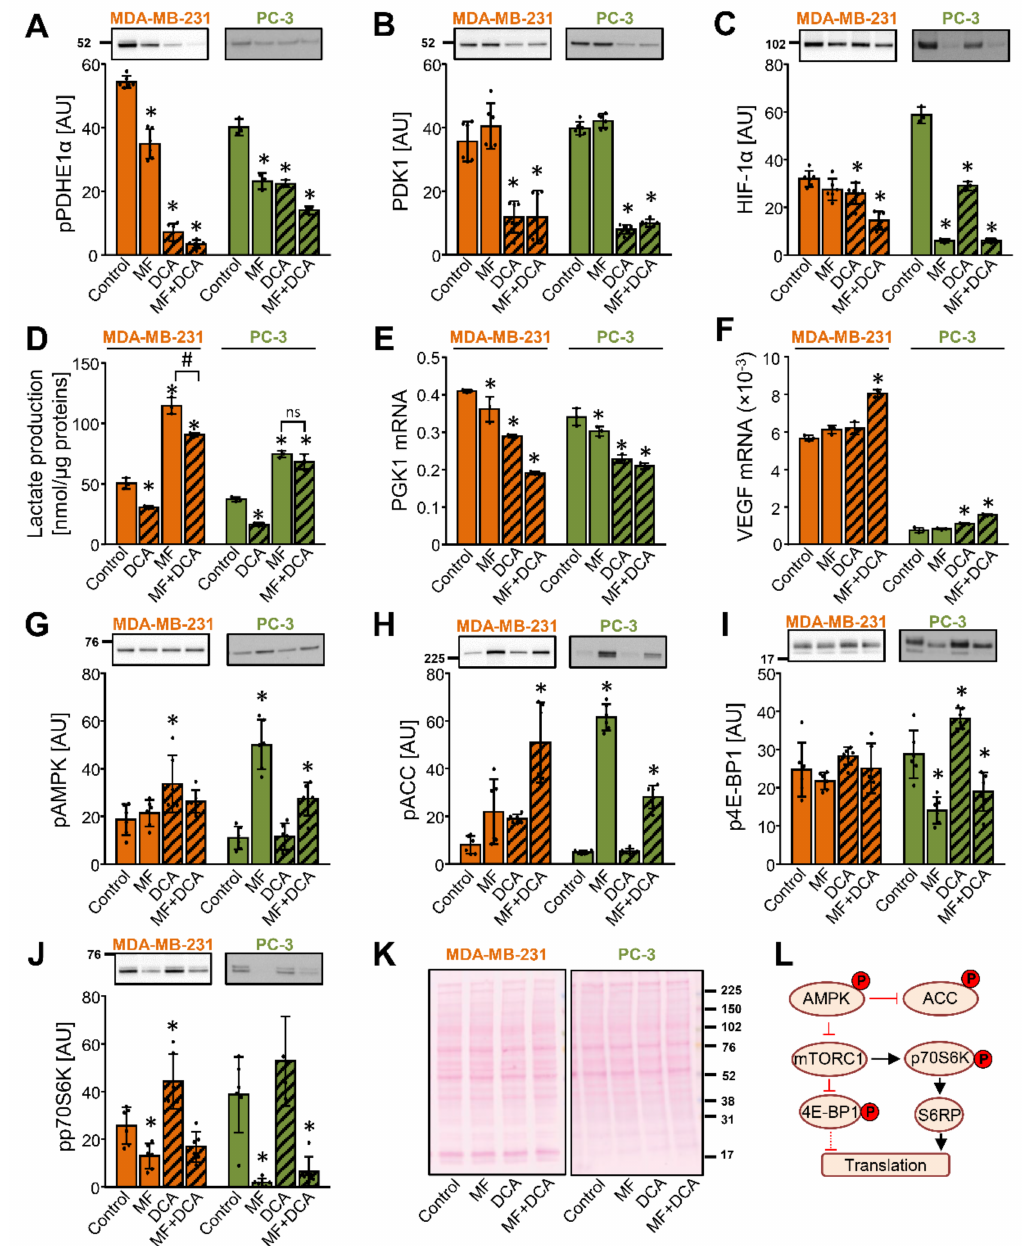
Figure 5. Inhibition of the mTOR pathway does not contribute to the DCA-induced suppression of PDK1. ( A – K ) MDA-MB- 231 and PC-3 cells were treated with 5 mM metformin (MF), 10 mM DCA, or both in serum-free RPMI medium for 24 h. The protein level of ( A ) phospho-PDHE1 α Ser293 (pPDHE1 α ), ( B ) PDK1, ( C ) HIF-1 α , ( G ) phospho-AMPK α Thr172 (pAMPK), ( H ) phospho-ACC Ser79 (pACC), ( I ) phospho-4E-BP1 Thr 37/46 (p4E-BP1), and ( J ) phospho-p70S6K Thr389 was determined with immunoblotting. ( K ) Total protein loading was evaluated with the Ponceau S staining. Numbers next to the blots and Ponceau stains indicate molecular weight markers in kDa. Results are means ± SD of two experiments performed in triplicate ( n = 6). * p < 0.05 vs. Control. ( D ) Lactate production in MDA-MB-231 and PC-3 cells treated with 10 mM DCA and/or 5 mM metformin for 24 h. The mRNA expression of ( E ) PGK1 and ( F ) VEGF was measured with qPCR (endogenous control: cyclophilin). ( D – F ) Results are means ± SD of one experiment performed in triplicate for each cell line ( n = 3). * p < 0.05 vs. Control and # p < 0.05 as indicated ( L ) Schematic overview of the AMPK and mTOR signaling. Phosphoproteins that were evaluated in this study are indicated with P in a red circle. S6RP: S6 ribosomal protein. For other abbreviations, see the